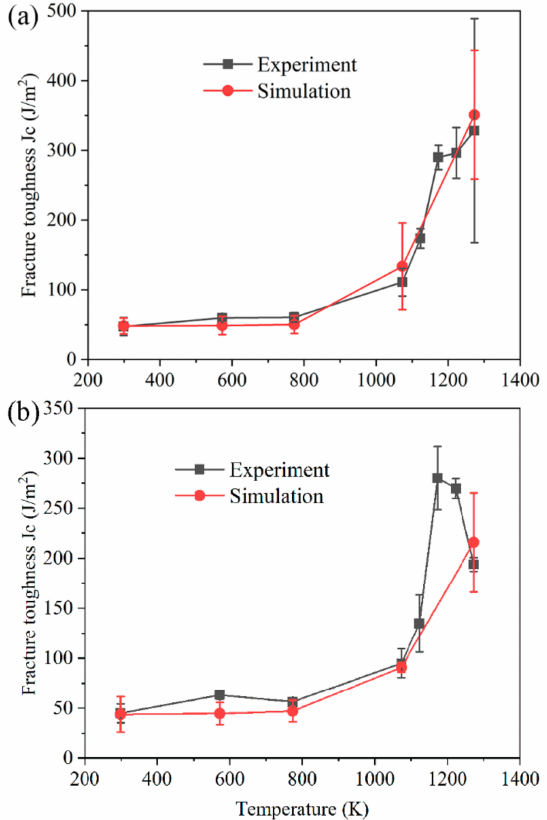
Figure 9. Experimental and simulated fracture toughness J C of the CT specimen with crack length-to-width ratios of ( a ) 0.4 and ( b )